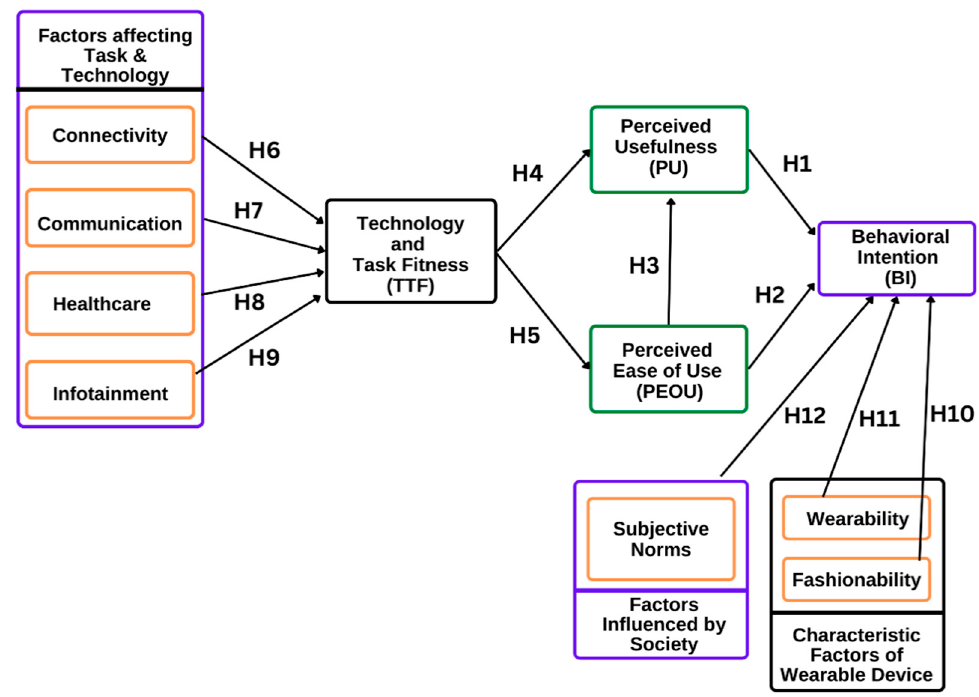
Figure 1. Proposed research model.